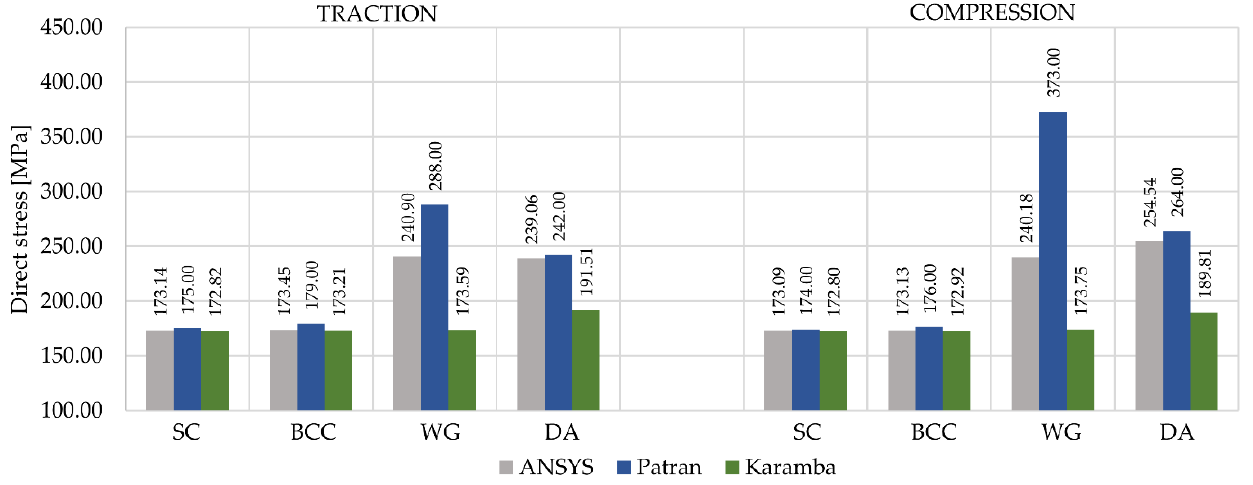
Figure 11. Direct stress results of the traction and the compression load cases, according to the FEM software.